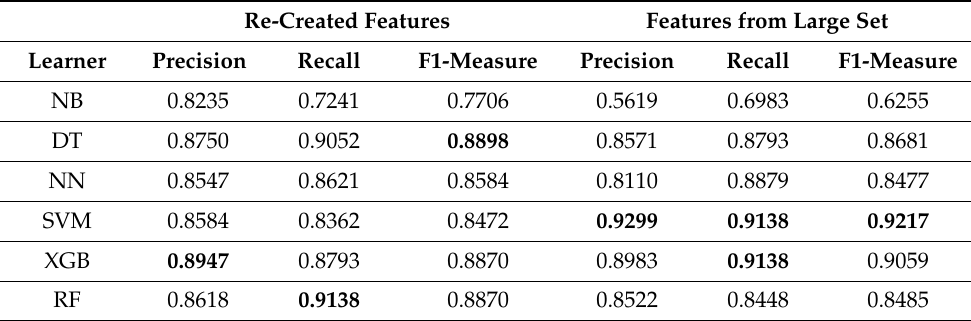
Table 9. Cross validation results on manually labeled gold standard, using user and tweet features. We distinguish a setup with re-created features for the manually labeled dataset, and re-using features from the large dataset. The best results are marked in